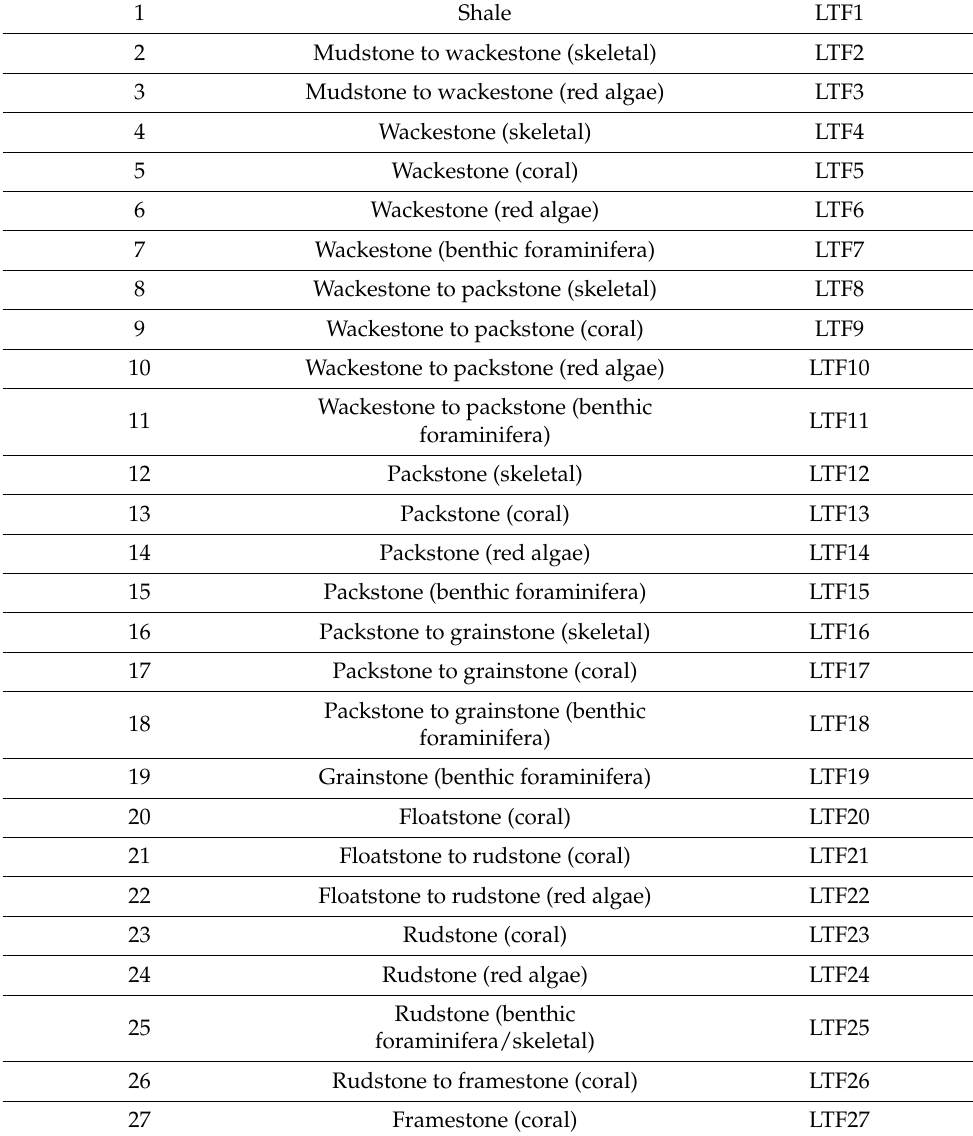
Table 3. List of 27 lithofacies types used to describe the E11 field.